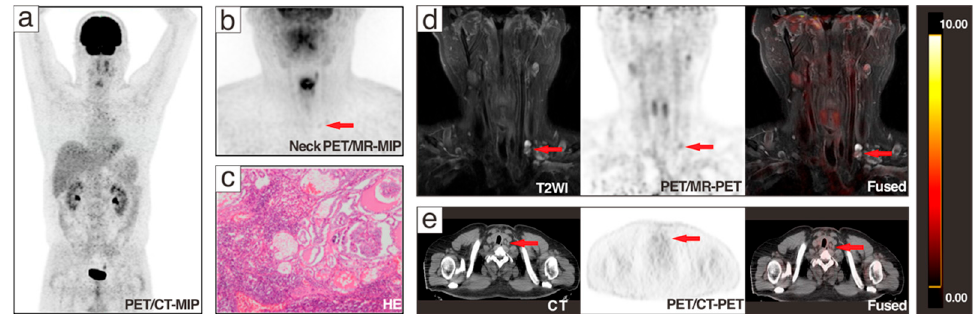
Figure 3. A 36-year-old patient with Tg 39.1 μ g/L and negative 131 I-WBS after comprehensive treatment was admitted to 18 F-FDG PET/CT and underwent additional neck PET/MR. PET/MR clearly presented the morphological and metabolic changes of lymph nodes in the VB region (( b , d ), red arrows). PET/CT showed no significant changes in the corresponding lesions (( a , e ), red arrows). After reoperation, 1 lymph node in the left VB, 8 lymph nodes in the left level IIA, 7 lymph nodes in the left level III, and 10 lymph nodes in the left level IV were taken for pathomorphological examination, and only the lymph node in the VB was pathologically diagnosed to be a metastatic lymph node ( c ).